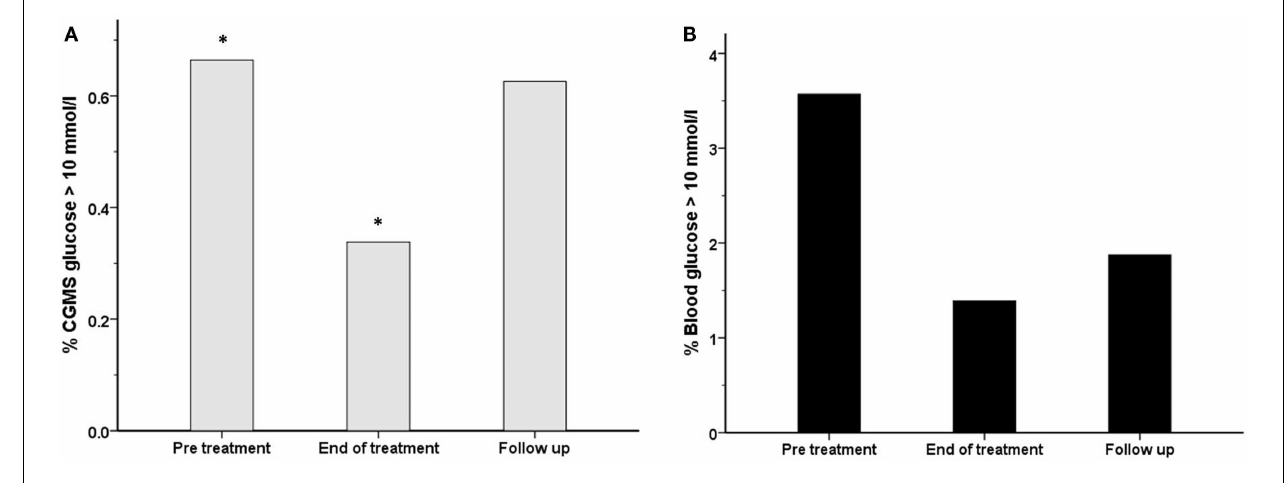
frequency of blood glucose > 10mmol/l from 3.6% (pre-treatment) to 1.4% (end of treatment), p = 0.27. Similarly, the frequency of CGMS glucose > 10mmol/l was reduced from 0.7 to 0.3%, * p = 0.004.